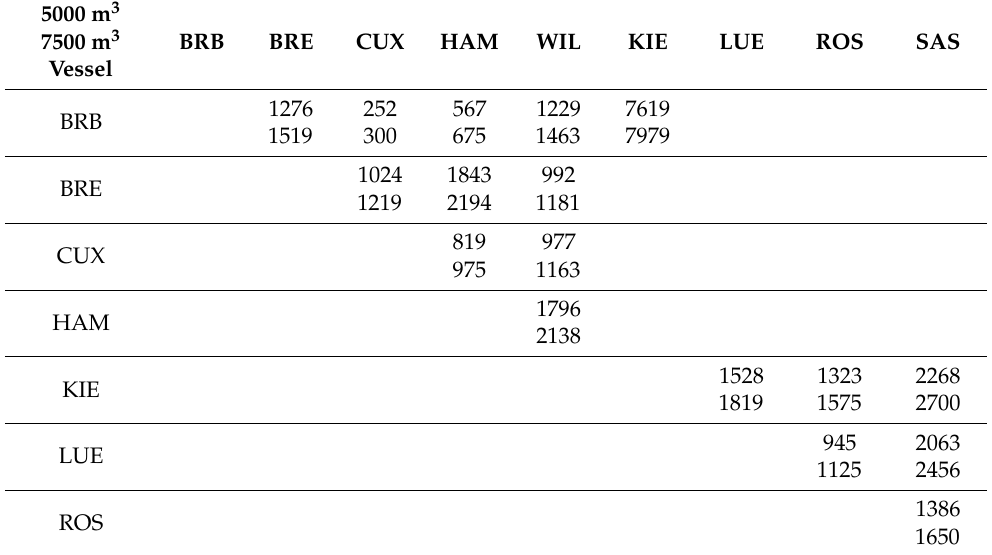
Table 3. Voyage costs between the German ports (authors’